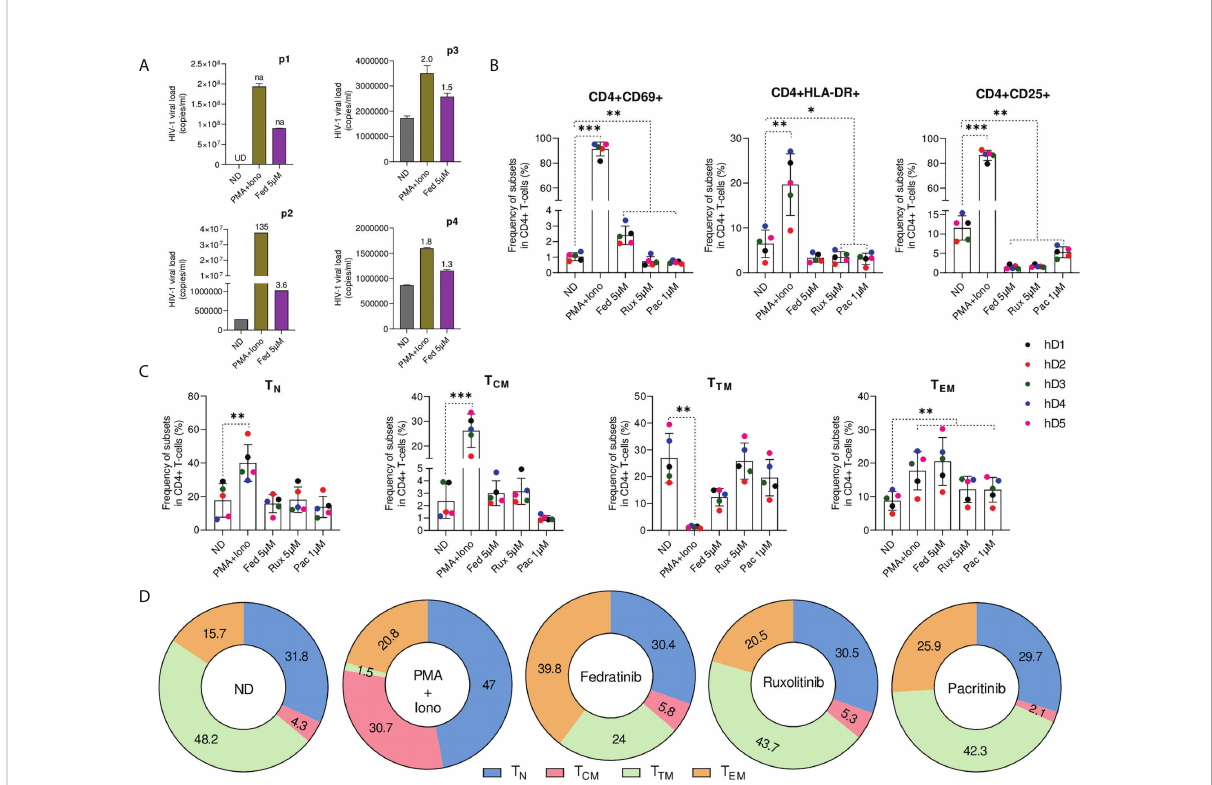
FIGURE 2 Fedratinib induces HIV-1 reactivation in the absence of immune activation in primary CD4+ T lymphocytes ex vivo. (A) Quanti fi cation of HIV-1 RNA in the cell culture supernatant of isolated CD4+ T cell from ART suppressed HIV-1+ individuals treated with fedratinib. PMA+Iono was used as a positive control for HIV-1 latency reactivation. Absolute HIV-1 copy number (copies/ml) for each HIV-1+ individual are represented as bar plots, and fold changes (FC) relative to the corresponding untreated replicate (ND) are indicated above treatment bars. Undetermined ct values (UD), and FC values if not available (na) are highlighted in the chart. (B) Immune cell activation of JAKi-treated CD4+ T cells from healthy donors (n = 5). CD4+ T cells were stained with early (CD69) and late activation (HLA-DR and CD25) markers for fl ow cytometry 72 h post treatment with compounds. (C) Frequency of major CD4+ T cell subsets from JAKi-treated CD4+ T cells from healthy donors. T N , naïve T cells; T CM , central memory T cells; T TM , transitional memory T cells; T EM , effector memory T cells. (D) Corresponding contribution of individual CD4+ T cell subsets to the major CD4+ T cell pool analysed in (C) . Numbers inside sections indicate percentages. Data are pooled from the fi ve healthy donors from (C) . Bars show mean ± SD ∗ p<0.05; ∗∗ p<0.01; ∗∗∗